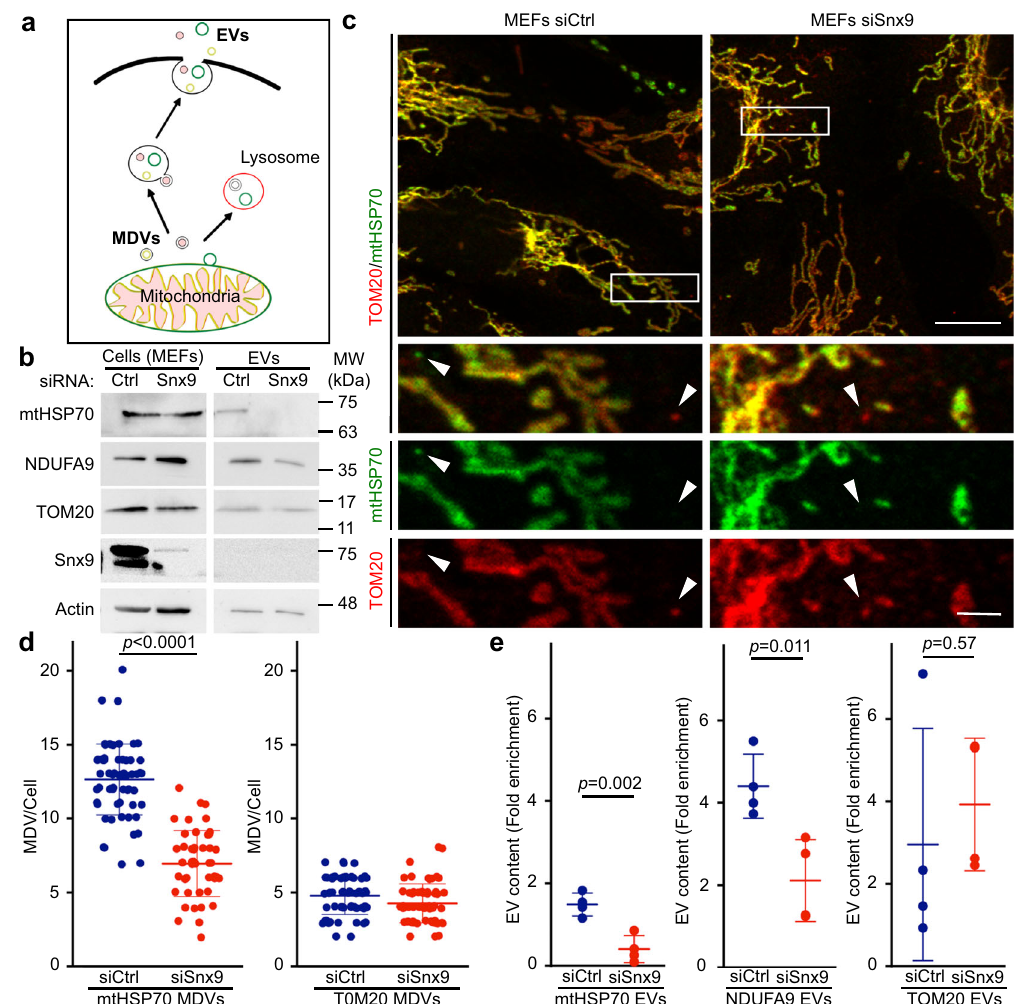
Fig. 3 Snx9-dependent MDVs contribute to the inclusion of IM/matrix proteins into EVs. a Schematic representation of the two distinct MDV pathways leading to EVs and lysosomes, respectively. b MEFs were treated for 24 h with a control siRNA (siCtrl, blue) or a siRNA against Snx9 (siSnx9, red). Mitochondrial proteins were then measured by western blot, with Actin serving as a loading control. c Representative images showing TOM20 and mtHSP70 MDVs in MEFs treated with a control siRNA (siCtrl) or a siRNA against Snx9 (siSnx9). Arrowheads denote MDVs (positive for one marker but negative for the other). Scale bars: top panels, 10 µ m; enlargements in bottom panels, 2 µ m. d MDV quanti fi cation from images as in (c). Each data point represents one cell. Bars represent the average of 40 cells in three independent experiments ± SD. Two-sided t -test. e Enrichment of the indicated mitochondrial proteins was measured by western blot as in Fig. 1. Individual points represent independent experiments ( n = 4). Bars are shown as average ± SD. Two-sided t